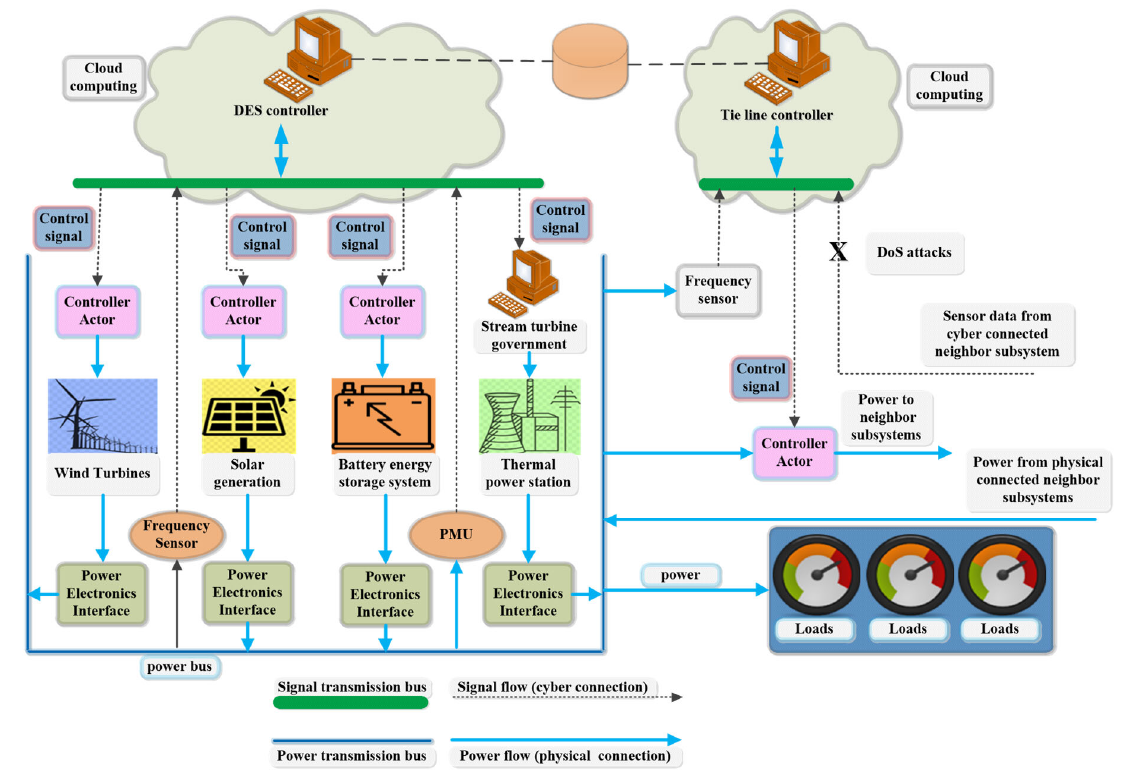
Figure 14. Schematic diagram of a subsystem.